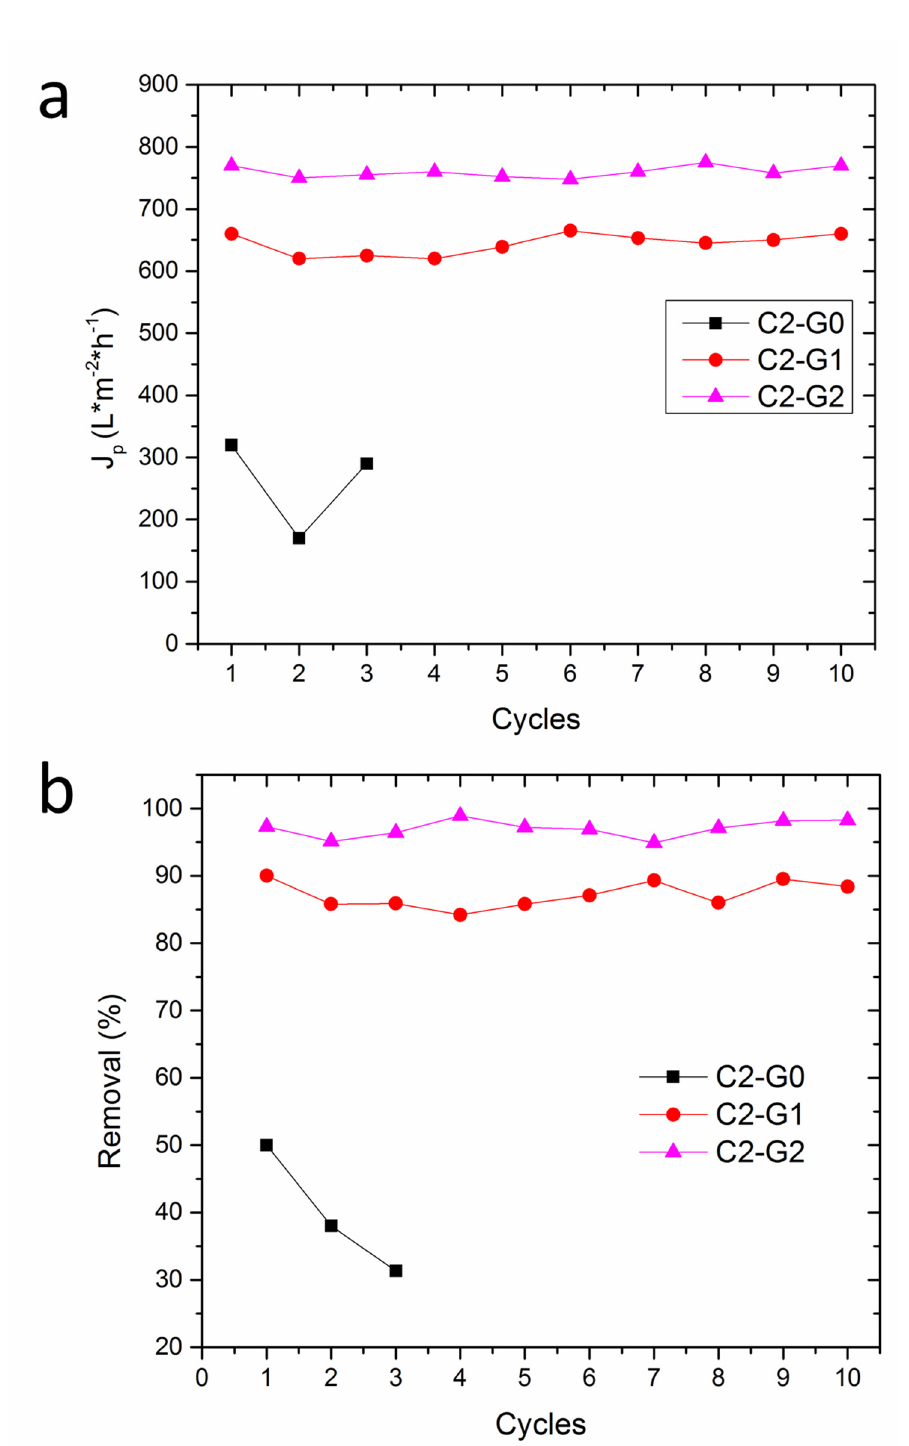
Figure 9. Reusability of the membranes in terms of flux ( a ) and removal ( b ), for up to 10 cycles.